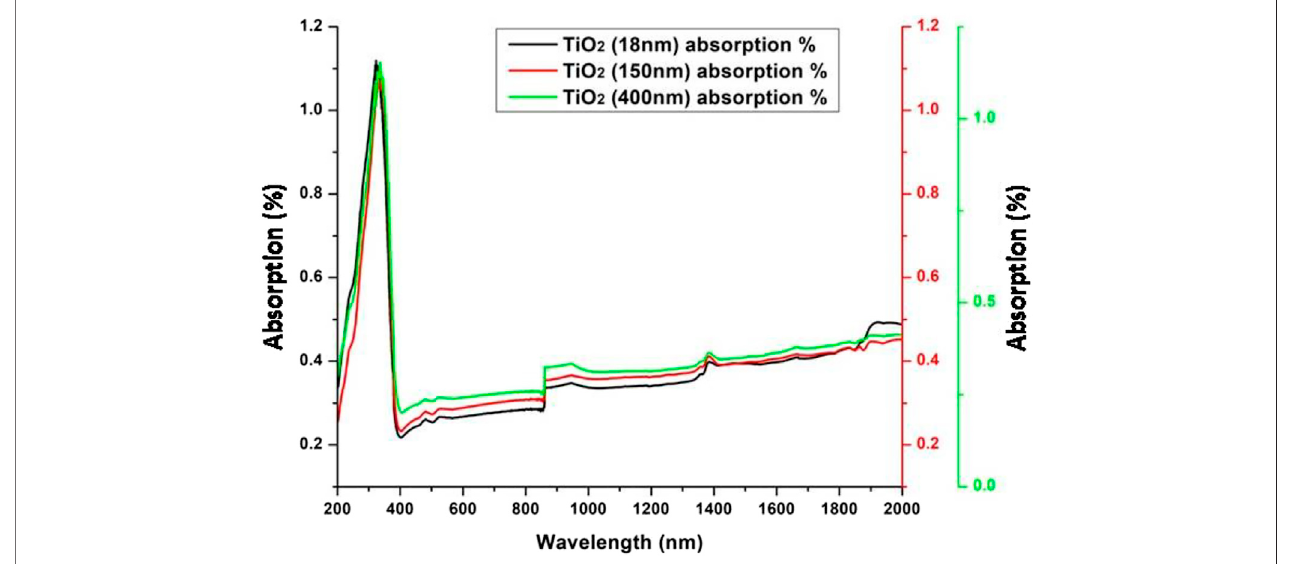
FIGURE 3 | UV-Vis spectra of as-received TiO 2